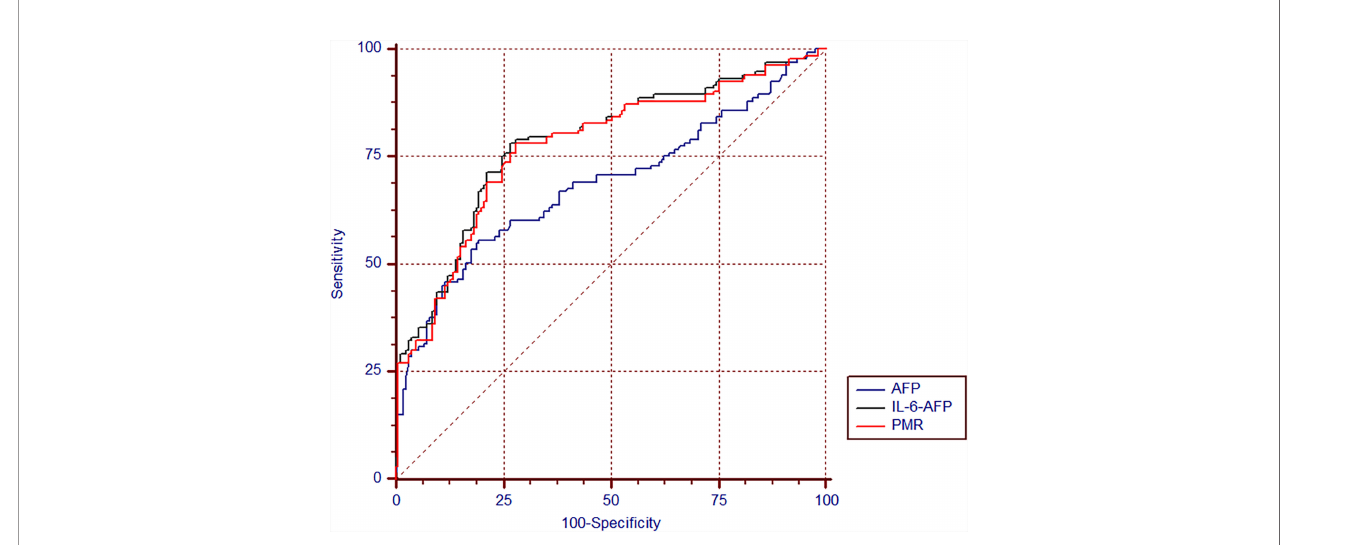
FIGURE 6 | The diagnostic value of IL-6 promoter methylation levels in HBV-associated HCC. The ROC of IL-6 promoter methylation level, AFP, and the combination of both tests in discriminating HBV-associated HCC from CHB.